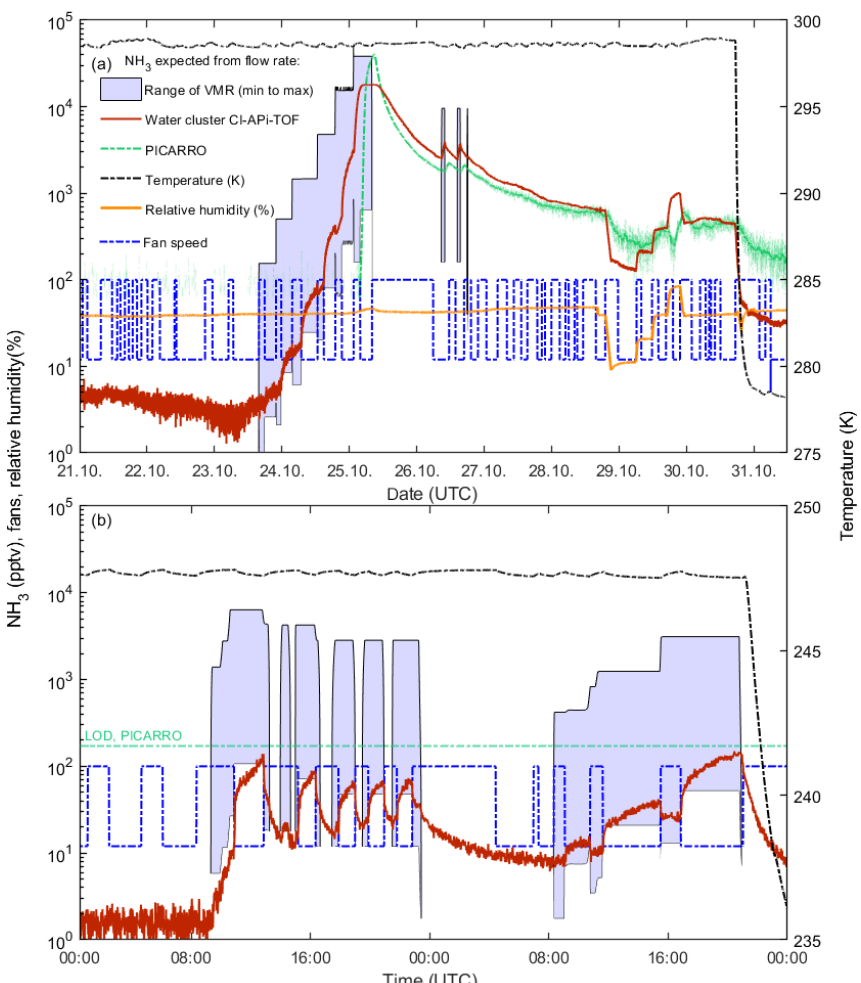
Figure 8. Intercomparison between calculated (shaded blue area) and measured ammonia mixing ratios (PICARRO: solid green line; water cluster CI-APi-TOF: solid red line) at CLOUD. The PICARRO background ( ∼ 200pptv) has been subtracted, while no background was subtracted from the water cluster CI-APi-TOF. The temperature inside the chamber is indicated by the dashed black line. The speed (percent of maximum, 397 revolutions per minute) of the two fans that mix the air inside the chamber is shown by the dashed blue line. The calculated ammonia mixing ratios (based on the calculated injection of ammonia into the chamber from the MFC settings) have a wide range due to uncertainties of the ammonia loss rate in the chamber. We display the maximum calculated range assuming, for the lower limit, that the chamber walls act as a perfect sink (wall loss dominated; 25 and 100s lifetime for fan speeds of 100% and 12%, respectively) and, for the upper limit, no net uptake of NH 3 on the walls and a loss rate determined by dilution (6000s lifetime). For higher fan speeds, the lifetime decreases due to increased turbulence and, in turn, increased wall loss rate. Relative humidity is indicated by the orange line. The water cluster CI-APi-TOF reacts rapidly to changing conditions, such as the ammonia flow into the chamber, relative humidity, temperature or fan speed. At low concentrations, the ammonia lifetime is determined by the wall loss rate (panel b and initial stages of panel a ). However, at high ammonia concentrations, the walls of the CLOUD chamber progressively become conditioned as a source of ammonia, with corresponding increases in the ammonia lifetime and the time to reach new equilibria at lower ammonia flow rates (later stages of panel a